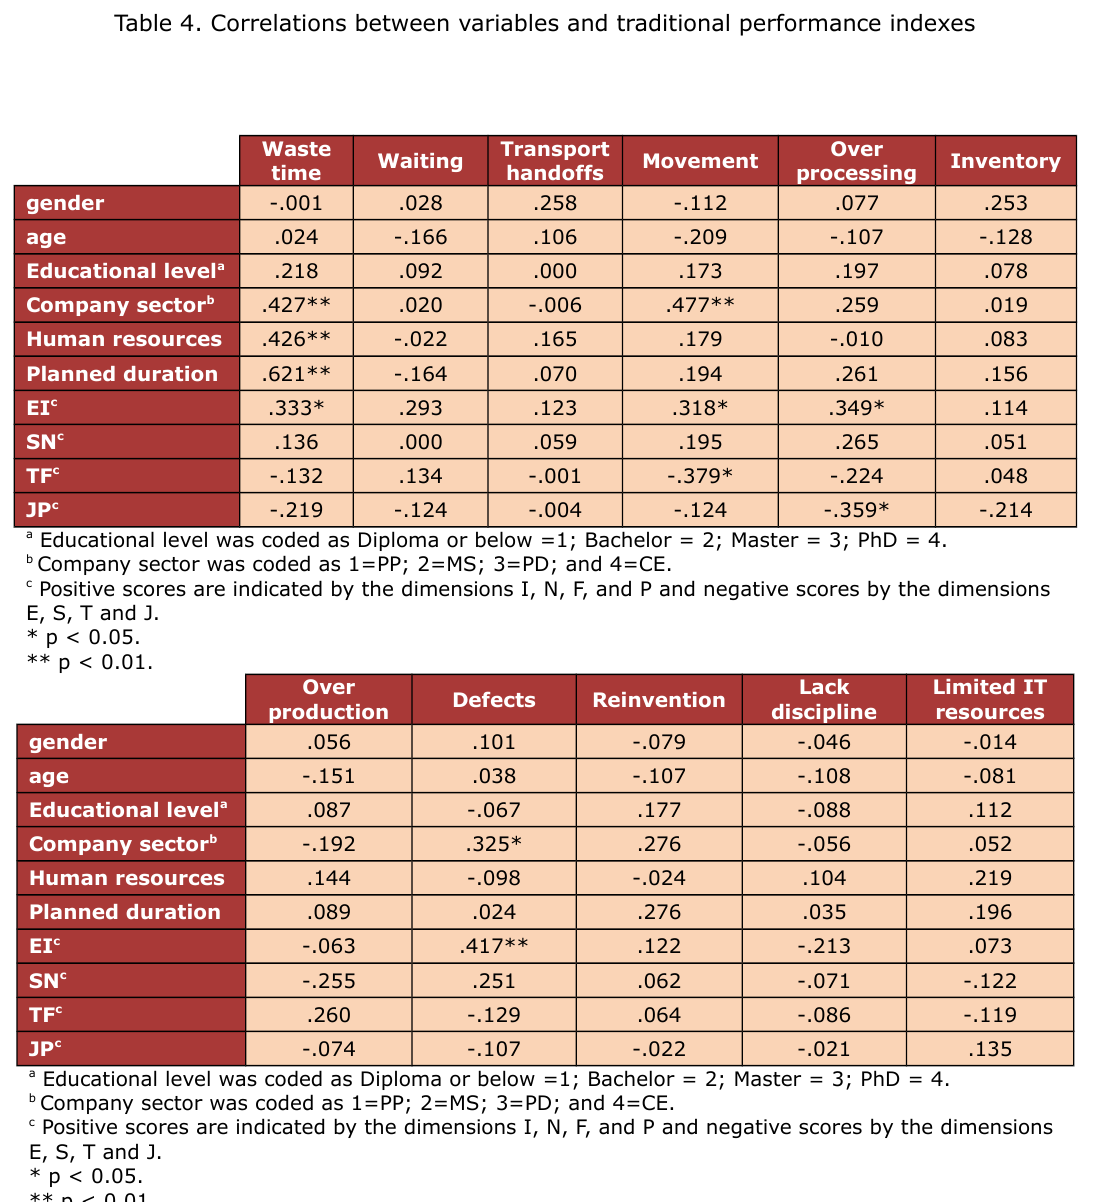
Table 5. Correlations between variables and performance indexes based on VSM